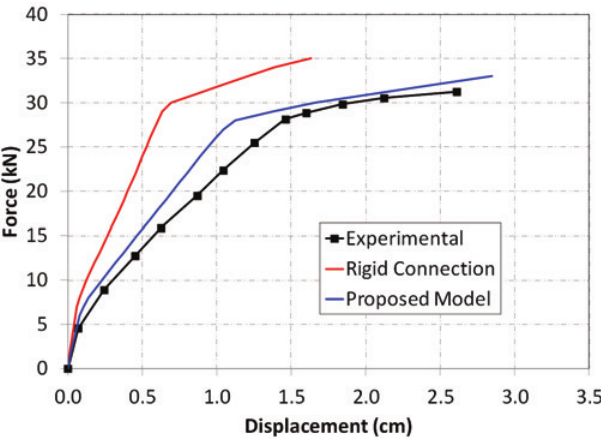
Comparação entre resultados teóricos com o modelo proposto por [21] e experimentais de uma ligação viga-pilar monolítica em concreto armado – Lee, Wight e Hanson [29]: Specimen